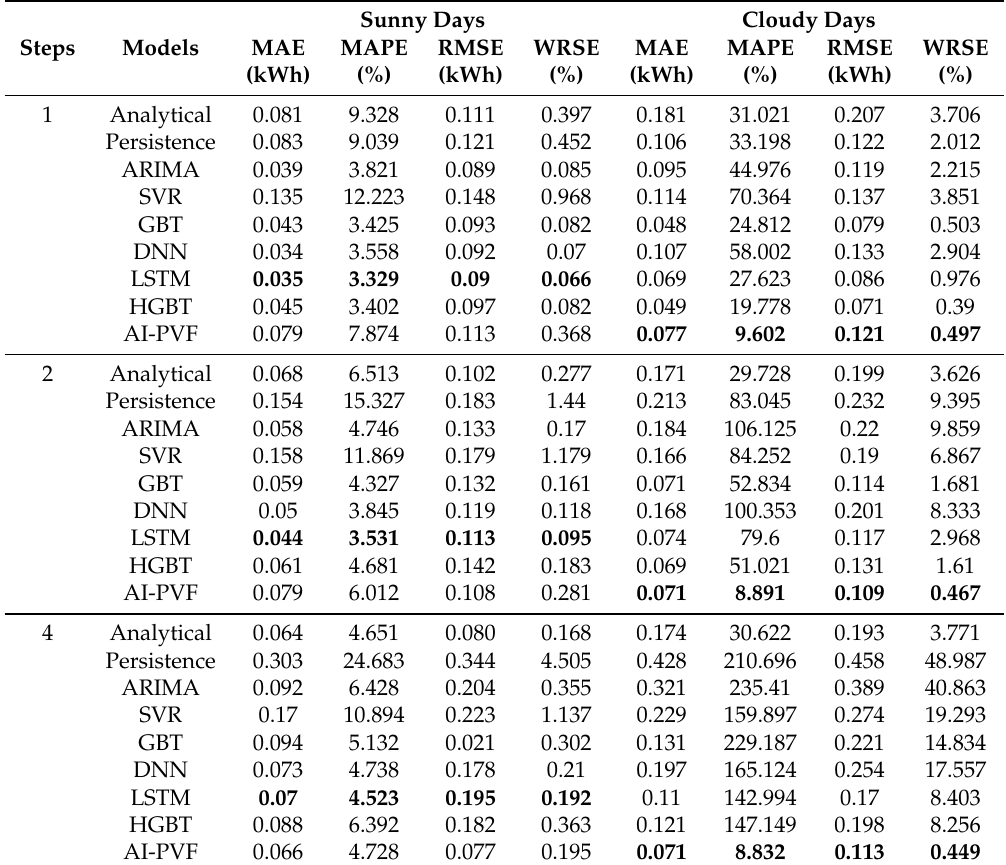
Table 4. Forecasting accuracy results for the summer